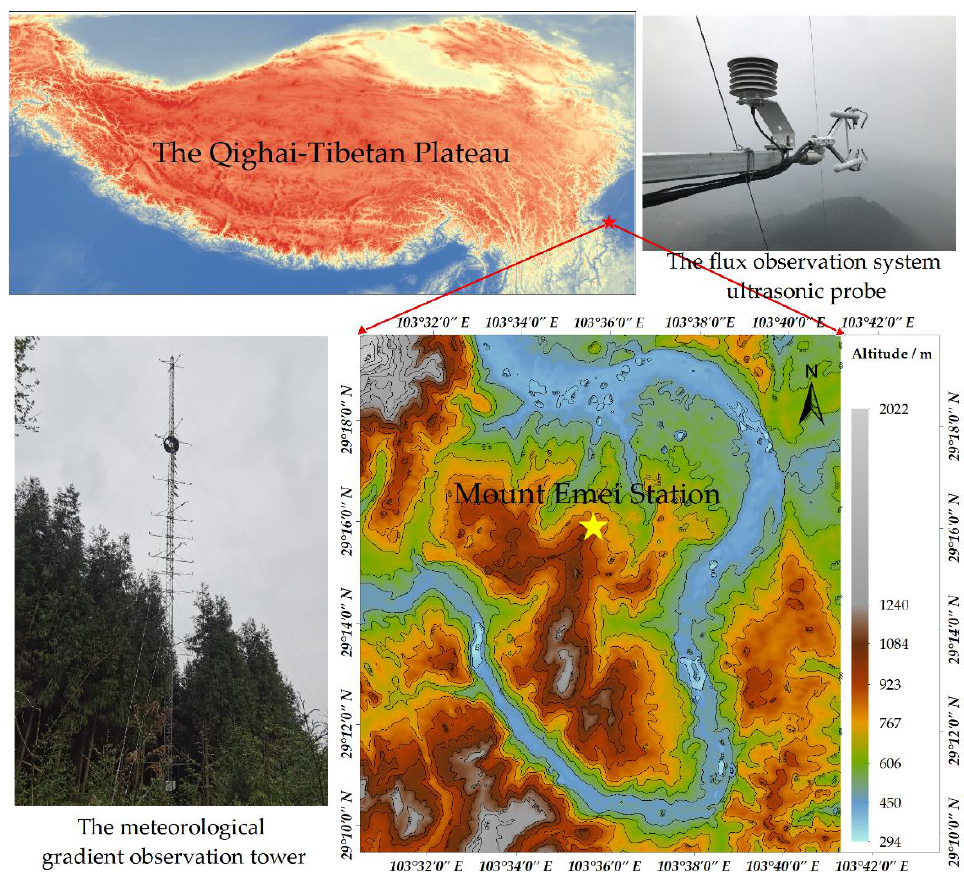
Figure 1. Topography of Mount Emei station and meteorological observation tower. is the station location.